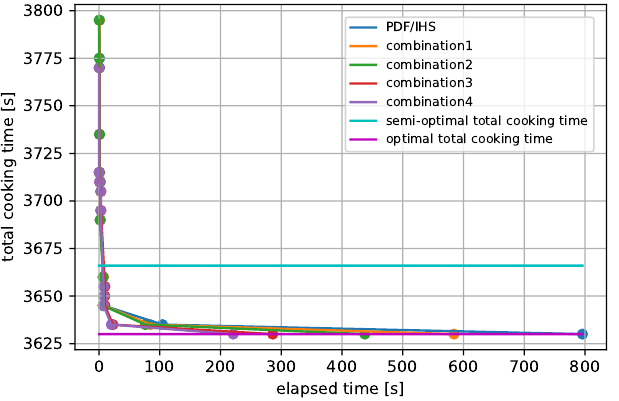
Figure 8. Tentative solution updates (menu